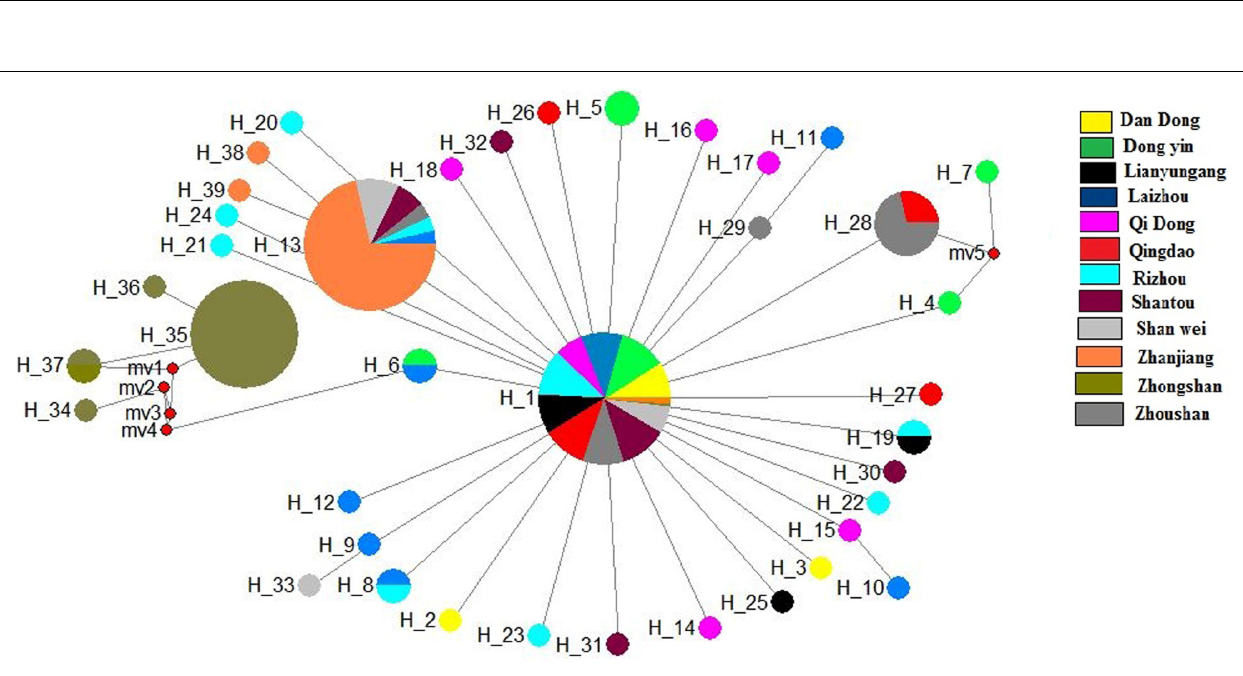
Frontiers in Marine Science |